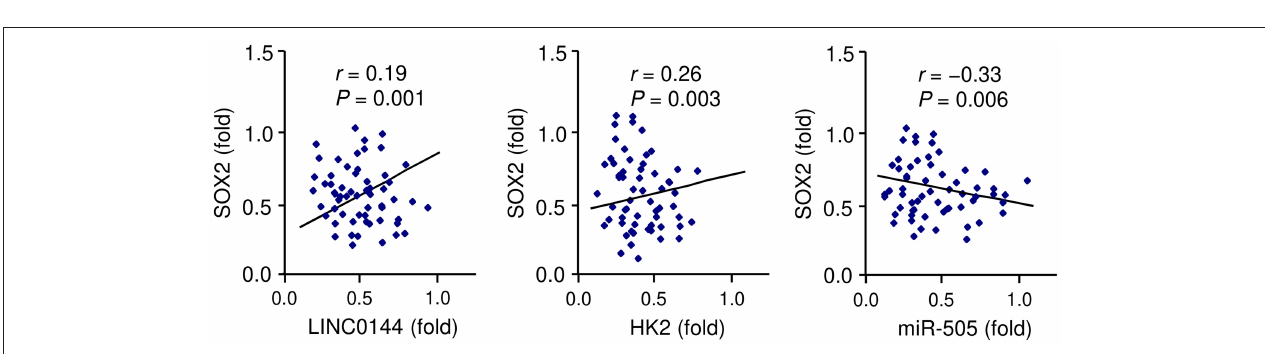
FIGURE 8 | Correlation between SOX2 and LINC01448/miR-505/HK2 expression in PC tissues, as determined by qRT-PCR